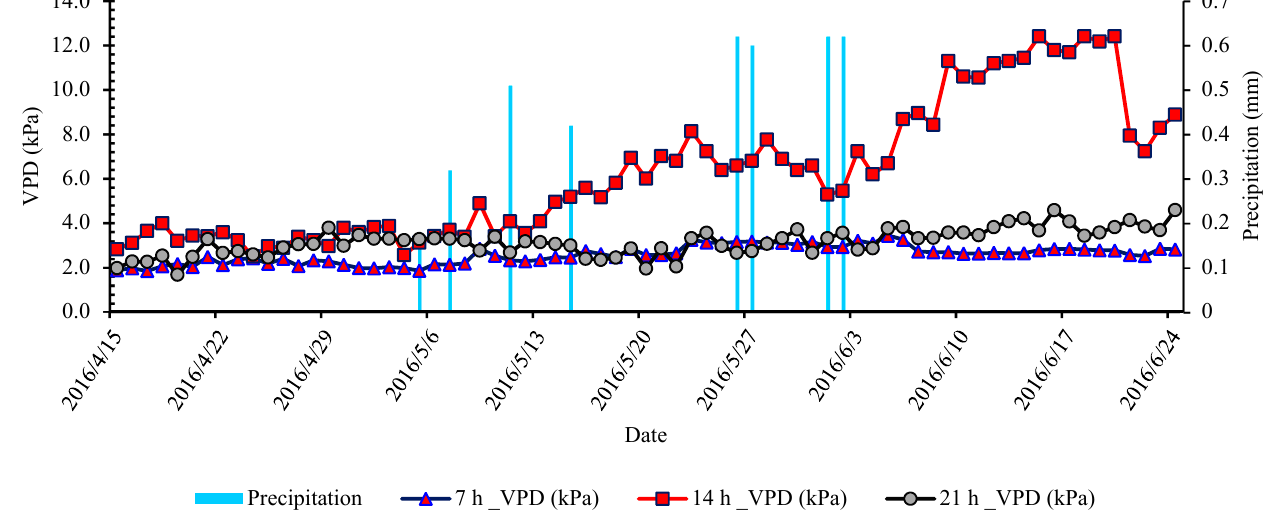
Figure 2. Average daily (24 h) vapor-pressure deficit (VPD) value and number of rainy days after commencement of the tests. VPD and precipitation (mm) in the field tests at 7:00 a.m., 2:00 p.m., and 9:00 p.m., and rainy days.